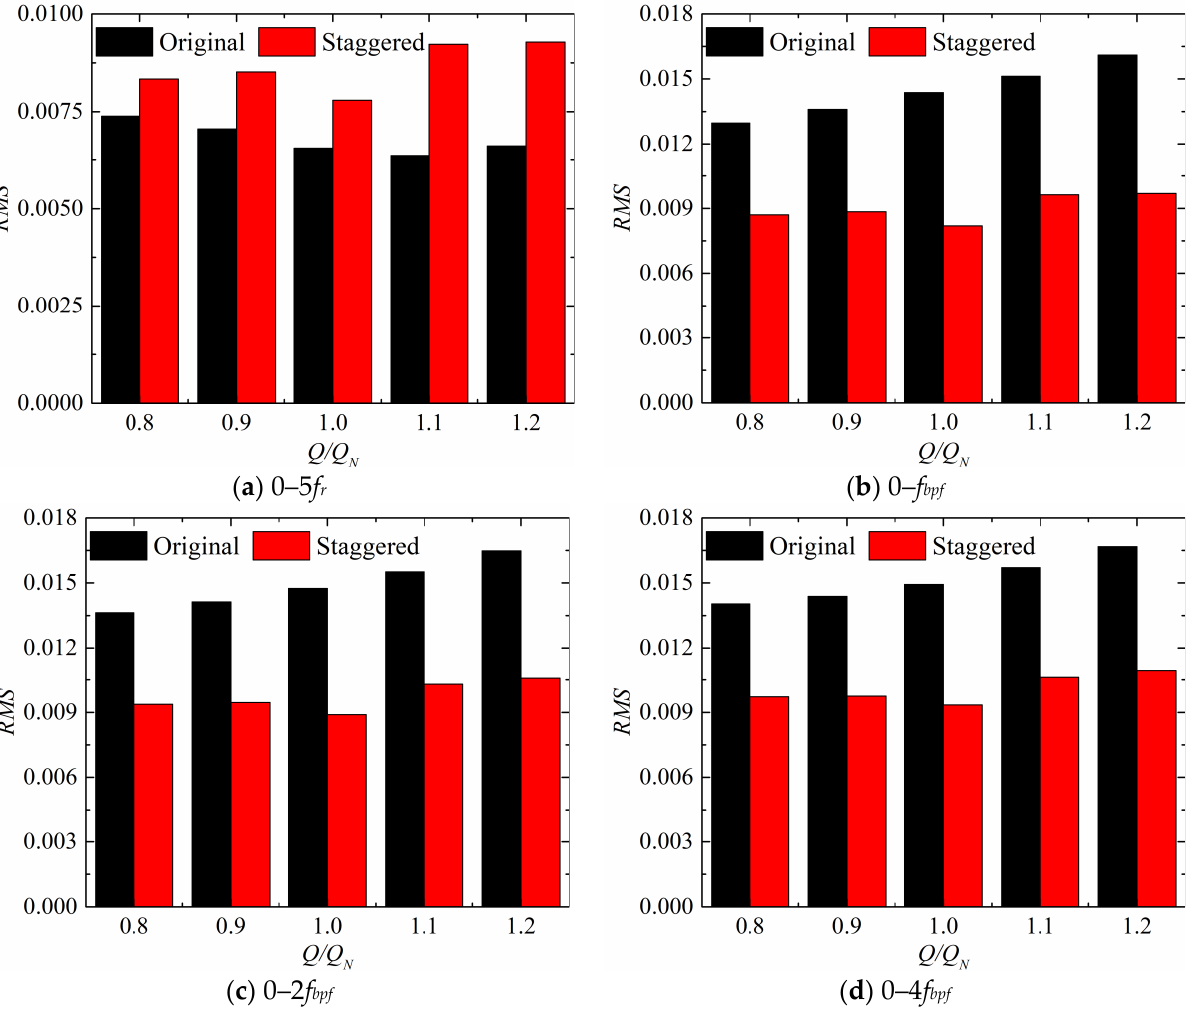
Figure 11. Comparison of pressure pulsation energy in different frequency bands under 0.8 Q N –1.2 Q N .